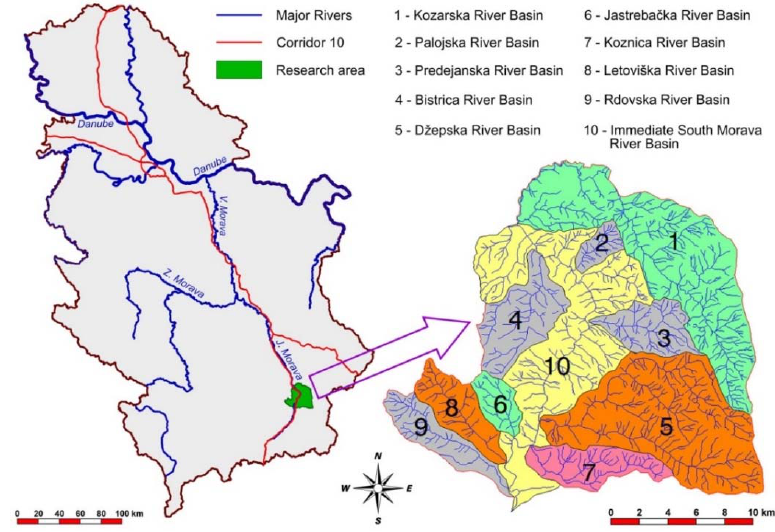
Figure 1. Study area: Grdelica Gorge in The South Morava River Basin, Serbia.